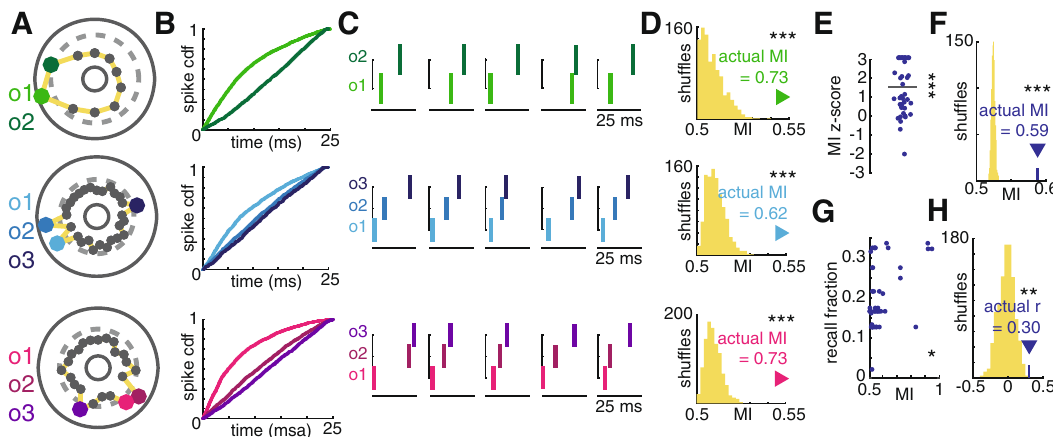
Fig. 2 | Consistent fi ring sequences during assembly activation predicts suc- cessful memory and may result from member neurons locking to different phases of the underlying gamma oscillation. A Schematics of three example assemblies with member neurons colored according to the expected fi ring order within activation events. B Cumulative distribution functions of spike times within activation events for each assembly member neuron, colored according to the key displayed in ( A ). C Spike rasters of assembly member neurons within fi ve example activationeventsdemonstratingtheexpected fi ringsequence. D ComparisonofMI foreachofthethreeassembliesfrom( A )toanulldistributionobtainedbyshuf fl ing spike times within activation events ( n =1000 shuf fl es, p =0.0009). E Distribution